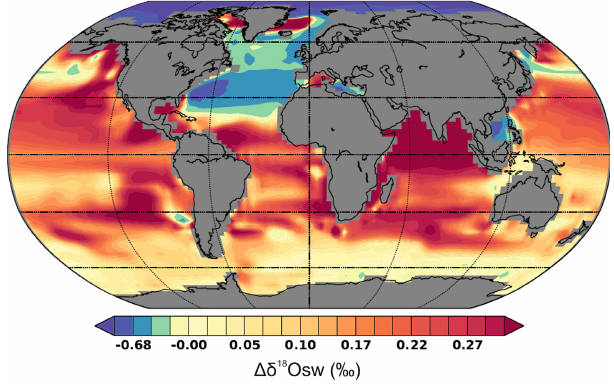
Figure 7. Comparison between simulated surface ocean calcite δ 18 O for the present day (CT) in i LOVECLIM (0–50m) (Caley and Roche, 2013) and global planktic foraminifera data (Table S1). For colour scale generation explanations see Fig. 1